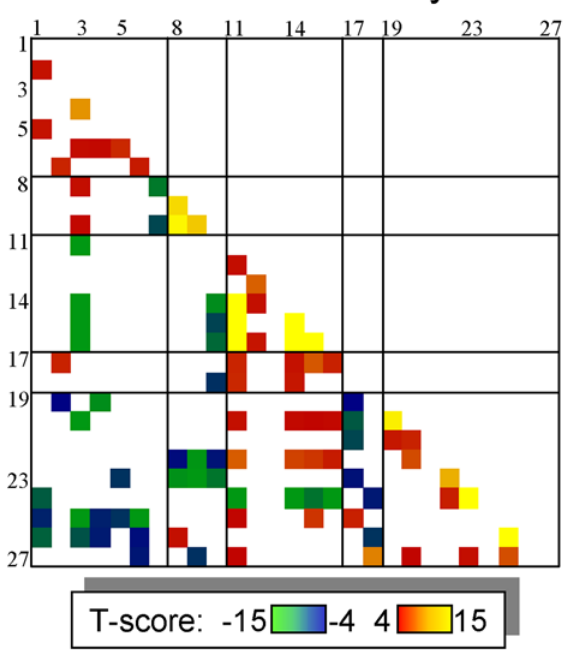
Figure 7. Functional Connectivity during gastric distention. Statistically significant cross-correlations among time-varying fMRI signals in the 27 ROIs listed in Table 1; Sample: 24 subjects, 90 fMRI runs; t-test; statistical threshold P c , 0.05 (Bonferroni correction for 351 comparisons).